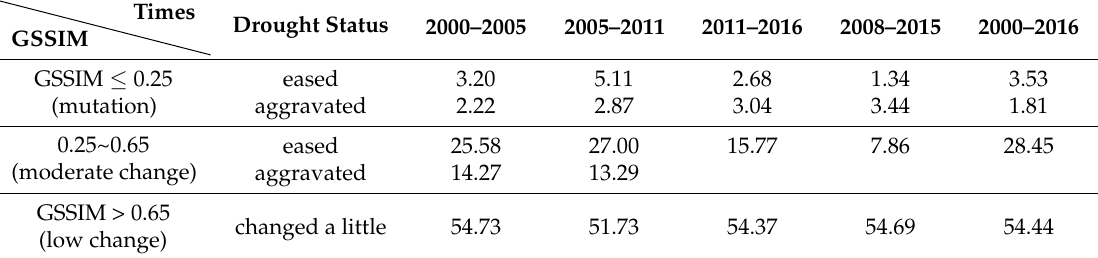
Table 2. The proportion of GSSIM in the Shaanxi province between 2000–2016 (%).